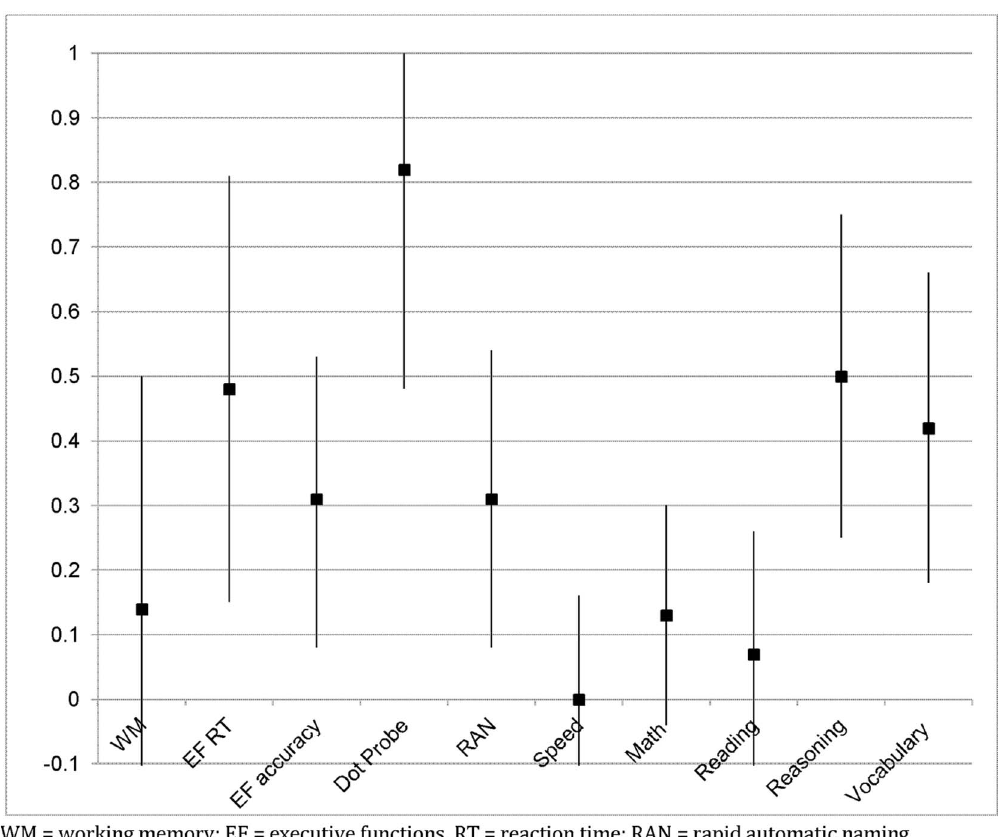
Figure 2. Effect size estimates for Tools of the Mind versus Control group comparisons in high poverty schools at the end of kindergarten. Error bars represent effect sizes at 6 1SE. ES = .82 [Figure 1b]. The effect of the curriculum on the Dot- Probe task was not seen, either in the sample overall or in high- poverty schools for attention as assessed by a simple reaction time task. The test of the effect of Tools of the Mind on the rapid